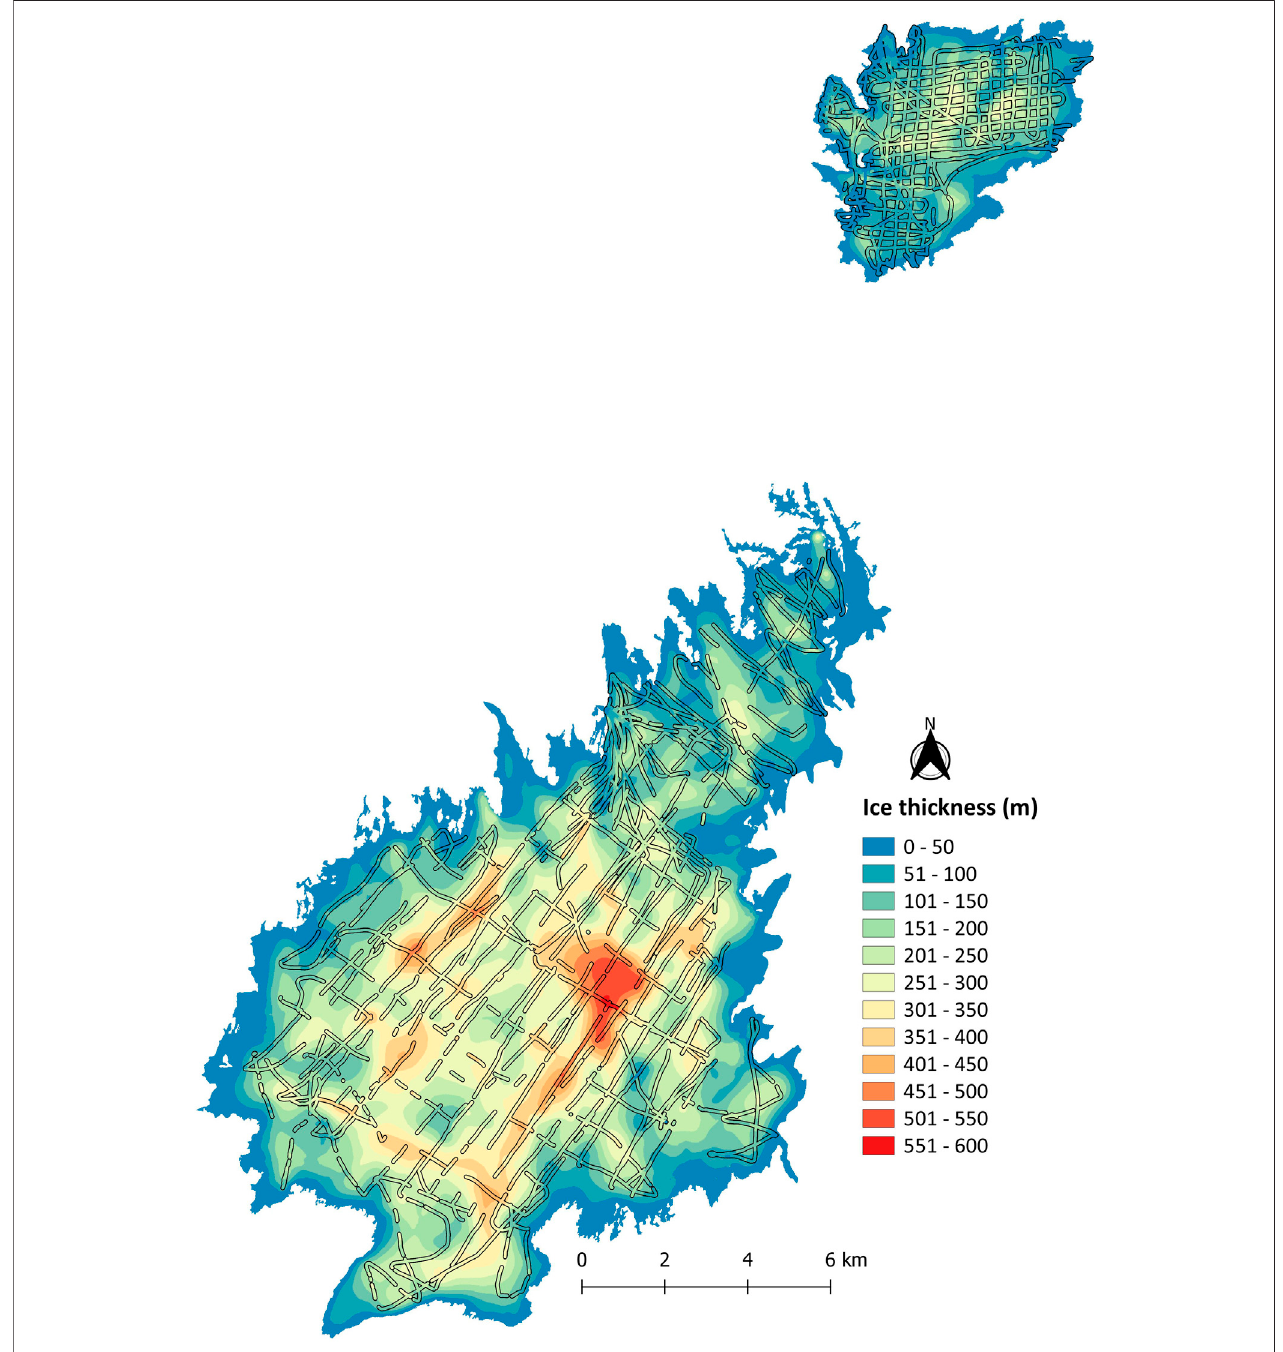
FIGURE 6 | Ice thickness calculated by subtracting the interpolated subglacial topography map from the 2013 glacial surface DEM (Kartverket, 2020). Within the black lines is the calculated ice thickness of all measured points used for the interpolation of subglacial bed topography.